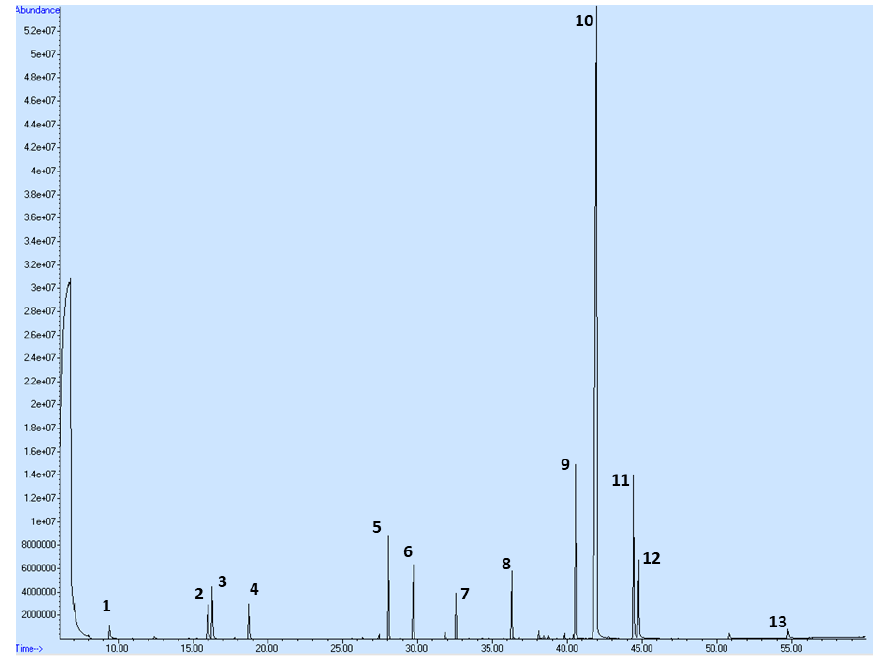
Figure 1. GC-MS chromatogram of the essential oil of C. zeylanicum L. bark (EOC) with the most abundant peaks. Numbering of peaks is explained in Table 1. Table 1. Relative abundance of the major compounds in C. zeylanicum essential oil.